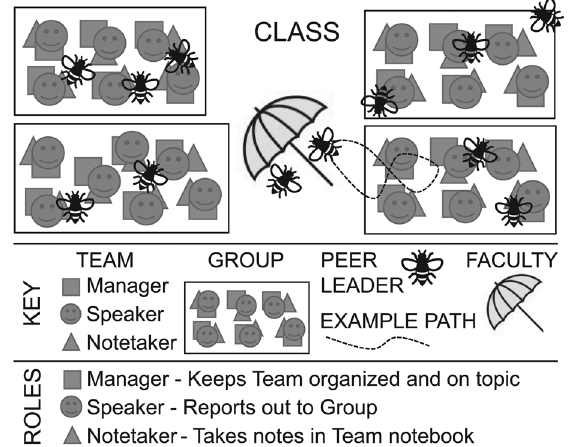
FIG. 1. Example classroom layout showing individual Teams of 3 students each, Groups of 6 – 7 Teams, the Peer Leaders, and the faculty. Peer Leaders travel between the Teams throughout their Group, returning to the instructor for additional assistance as needed; an example path is